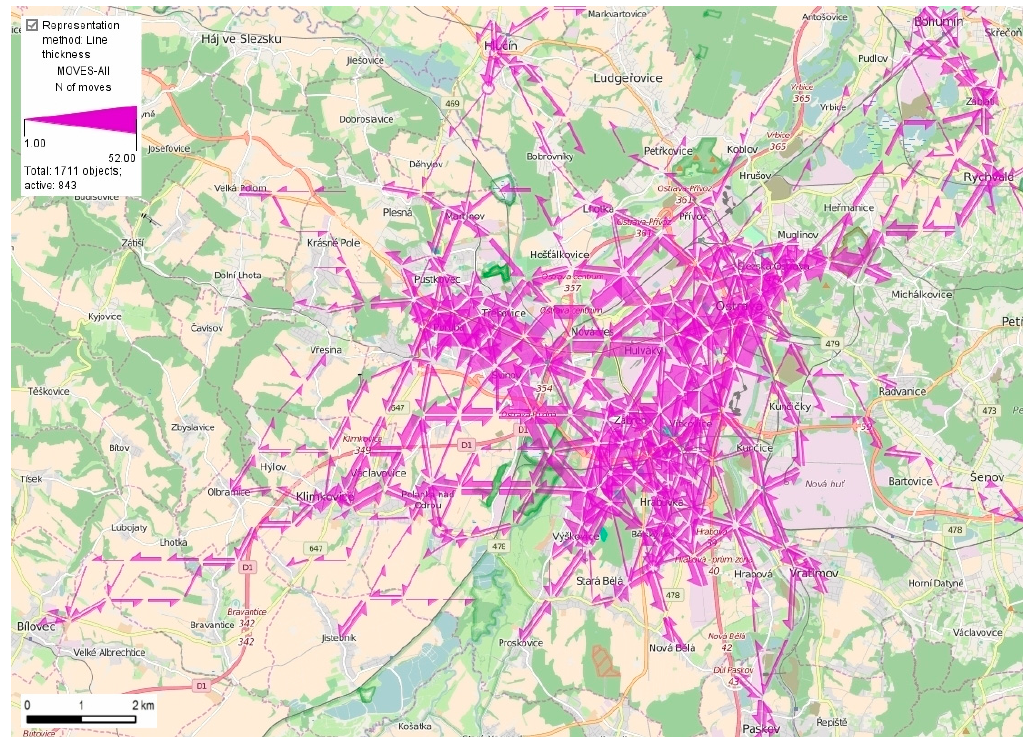
Figure 16. Dominant directions of movement in Ostrava according to the means of transport. Soc. Sci. 2018 , 7 , x FOR PEER REVIEW